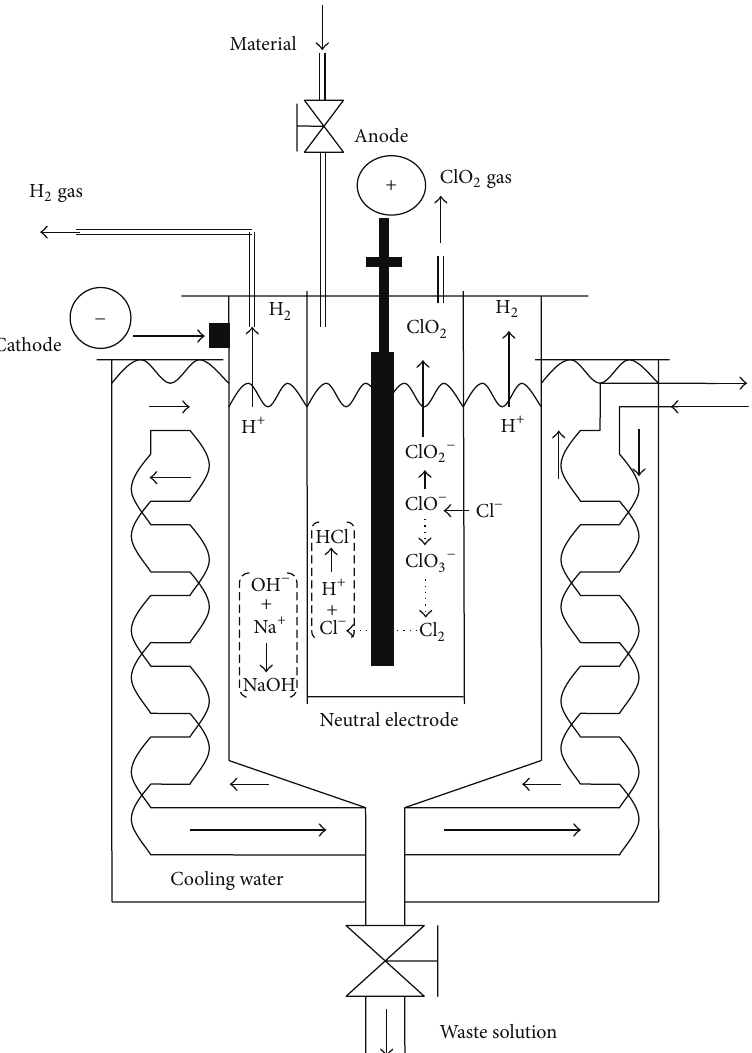
Figure 2: Internal structure and reaction of the electrolysis